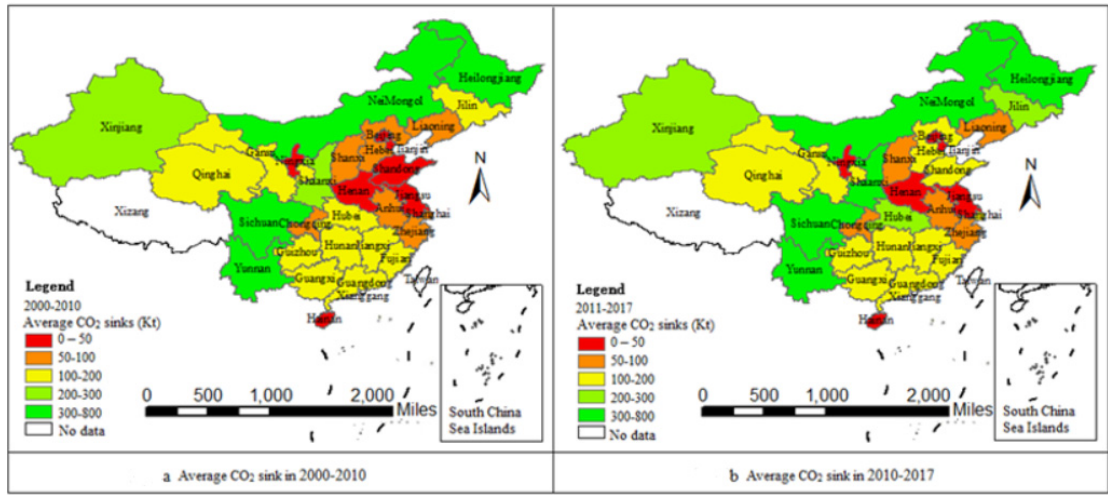
Figure 2. A spatial pattern of provincial CO 2 sink capacities (Kt) during ( a ) 2000–2010 and ( b ) 2010–